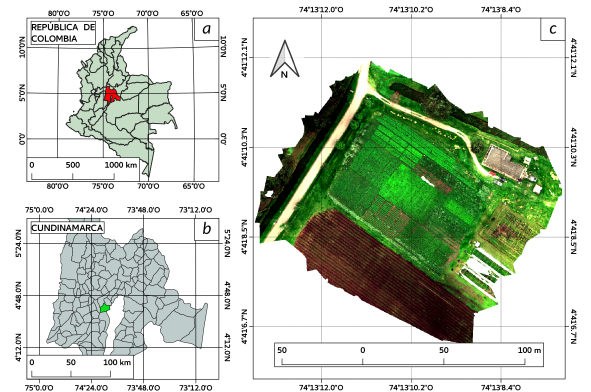
Figure 1. Overview of the study area, an experimental potato crop in Mosquera, Cundinamarca (Colombia). (a) Colombia’s political division (black colour) and major rivers (blue colour). (b) Detailed study area, municipalities division (light grey colour), Bogota D.C. Colombia’s capital (grey colour area), Mosquera municipality (green colour area), and major rivers (blue colour). (c) Potato crop - study area